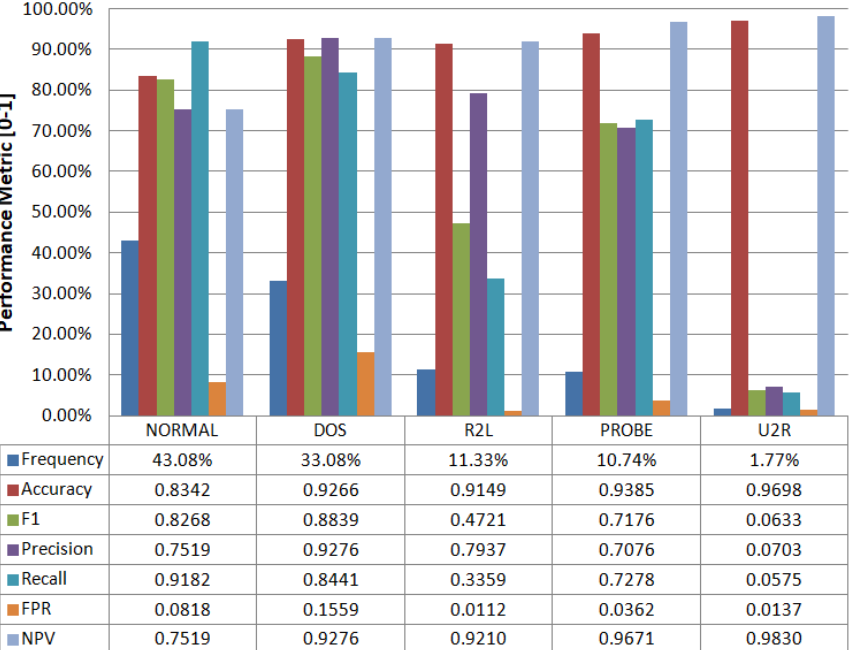
Figure 6. Classification performance metrics (One vs. Rest) vs. intrusion label.